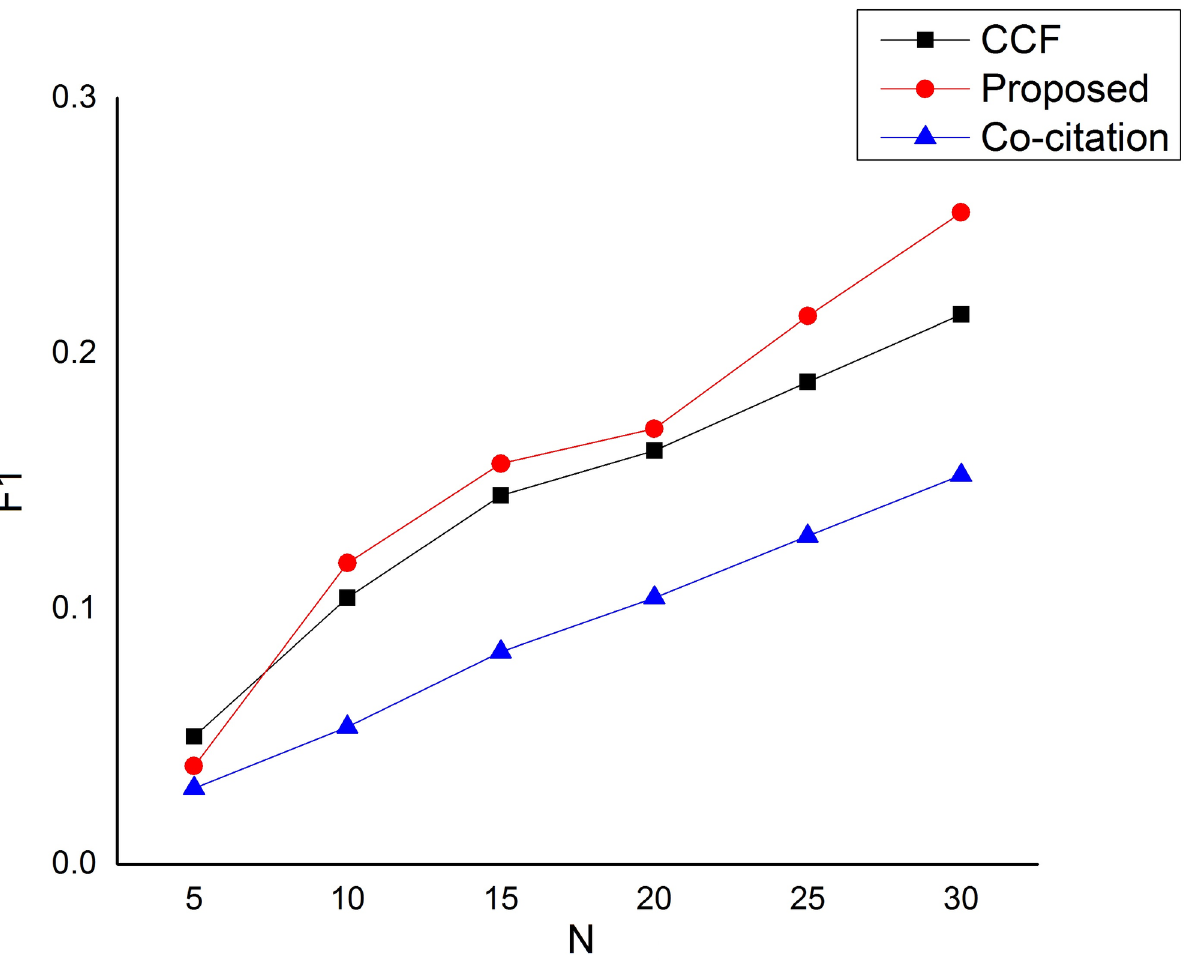
Fig 4. F1 performance on the